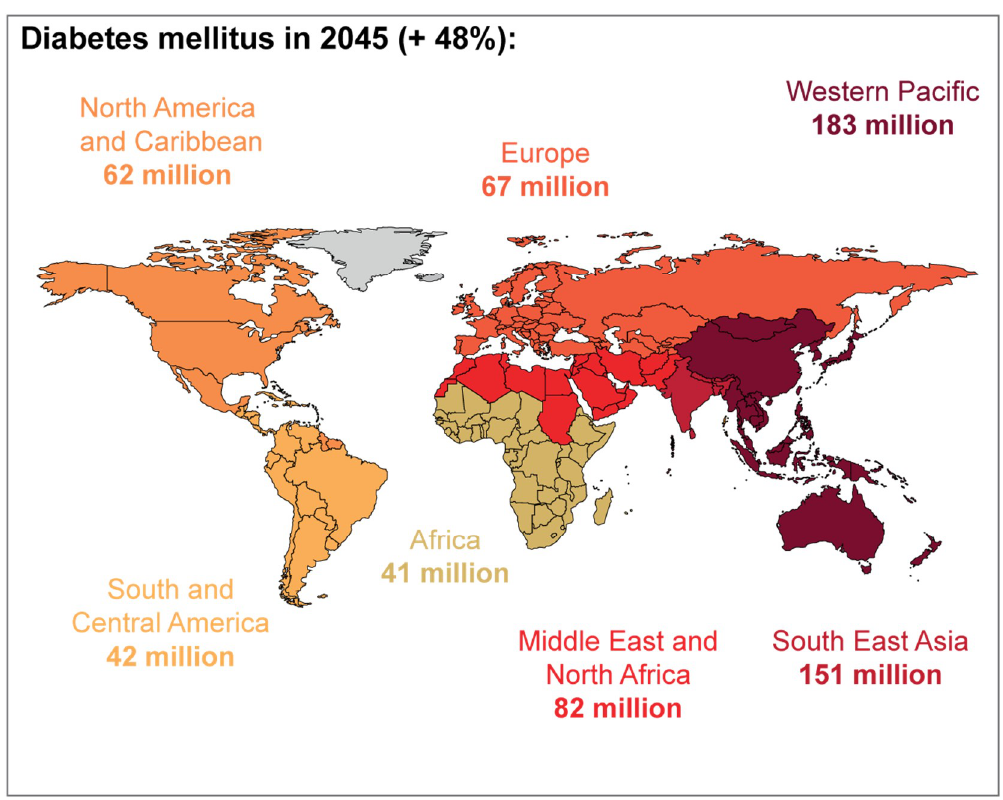
Figure 2. The estimated number of people with diabetes worldwide and per region in 2045 between 20–79 years in age, with a total of 629 million (source: International Diabetes Federation) (adapted image from GraphicsRF on stock.adobe.com).